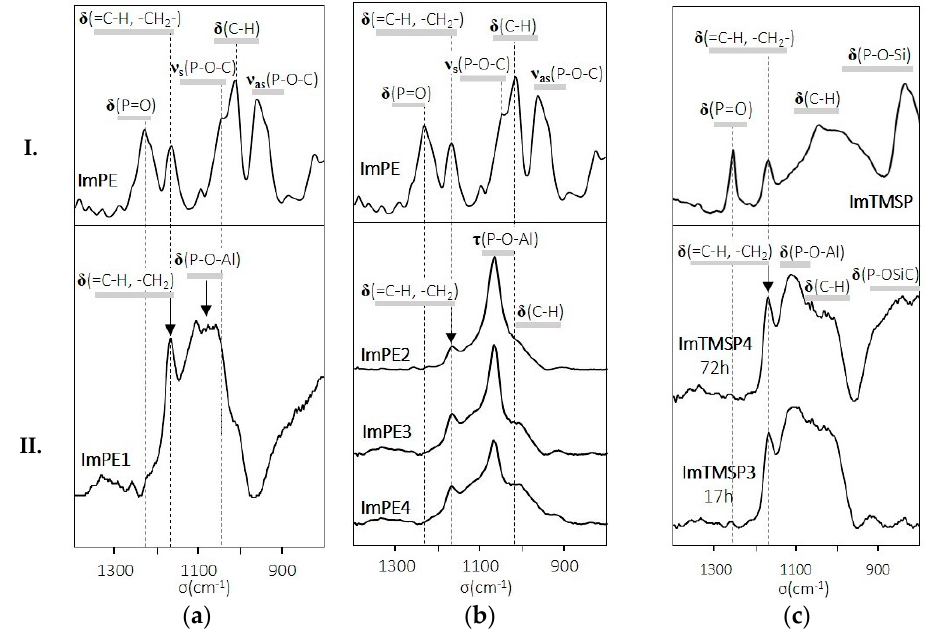
Figure 3. Experimental FTIR spectra of ImPE (I a , b ) and ImTMSP (I c ) and respective grafting on γ -Al 2 O 3 prepared under different reaction conditions: (II a ) with ImPE under standard condition (ImPE1), (II b ) with ImPE under forcing conditions (130 °C, 17 h) at different concentration (ImPE2 to ImPE4: two- to 12-fold excess) and (II c ) with ImTMSP under standard conditions (25 °C, six-fold